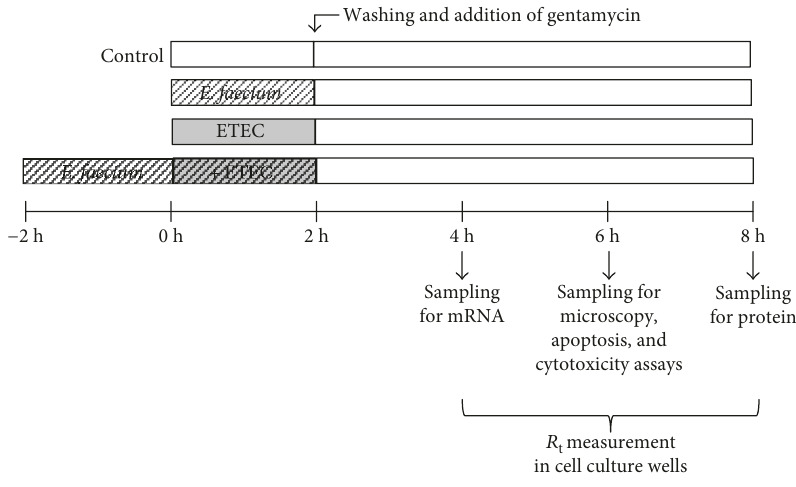
Figure 1: Experimental